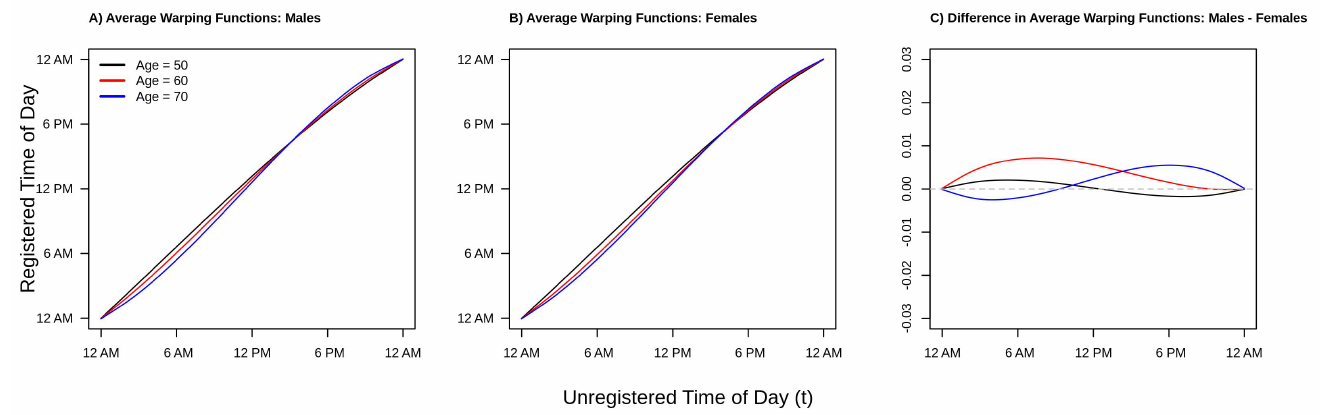
Figure 5. Estimated population average warping functions for Males ( panel A ), Females ( panel B ), and the estimated difference between Males and Females ( panel C ). separately for ages 50 (black), 60 (red), and 70 (blue) years old. Estimates of the lines presented in panels A/B are obtained by fitting a function-on-scalar regression (FoSR) model separately by sex where the population average warping function is allowed to vary smoothly in both time of day and age. The FoSR model is fit by modelling the average warping function as a tensor product smooth of marginal spline bases with cubic regression splines used in both the time and age domains. Panel C is obtained by taking the difference of panels A and